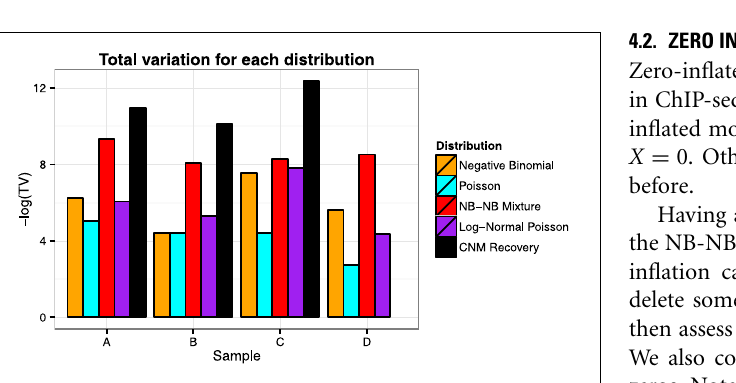
FIGURE 5 | Total variation. We see from the plot that the NB-NB mixture outperforms all of the other distributions, achieving the closest fit to the CNM estimate in the cases where it